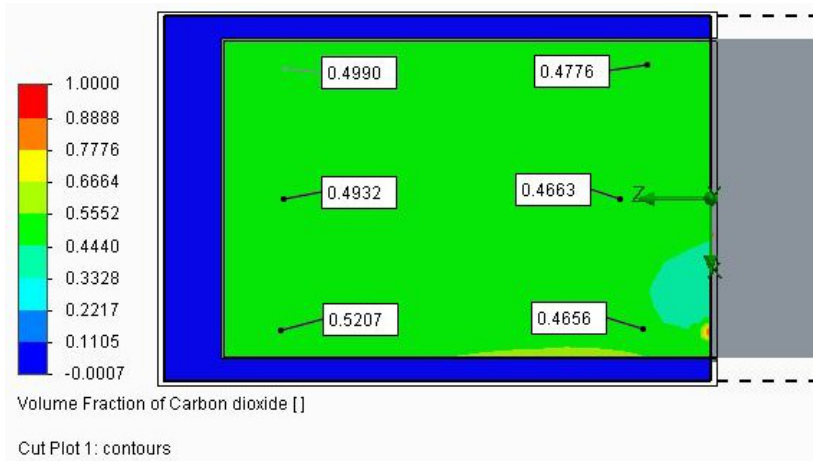
Figure 7. CFD results for the same analysis described in Figure 6, except that the 12 mm-wide slots area at the bottom edge of the long walls near the